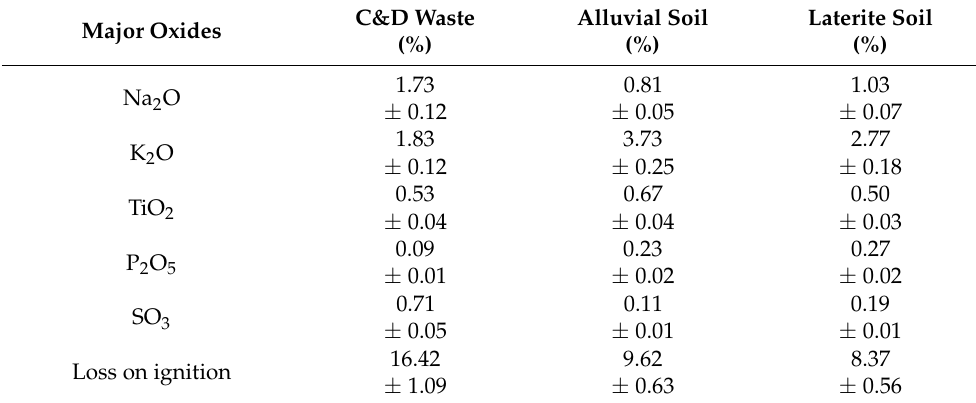
Figure 4. DTA/TGA curves of mixed C&D waste. The weight loss is approximately 4% when the temperature is raised from 30 °C to 200 °C due to the removal of free water and interlayer OH-groups, and trapped carbon dioxide. The burning of organic matter and impurities resulted in a ~2% weight loss from 200 to 400 °C, while the total weight loss is about 16%. The main exothermal reaction ap- peared at about 255 °C resulting from organic matter decomposition while being inter- rupted by an endothermic reaction at about 343 °C, which is due to the decomposition of ettringite [52]. Another endothermic effect noticed at 501 °C might be caused by the de- composition of portlandite. The characteristic endothermic peaks of the clay mineral de- composition at about 530–540 °C [46] were not seen in the DTA curve. The structural con- version of quartz is not seen in the DTA graph since it is overlapped with more intensive reactions of dehydration. The same is with the decarbonization of carbonates, which is detected only in the corresponding TGA curve at 762 °C.